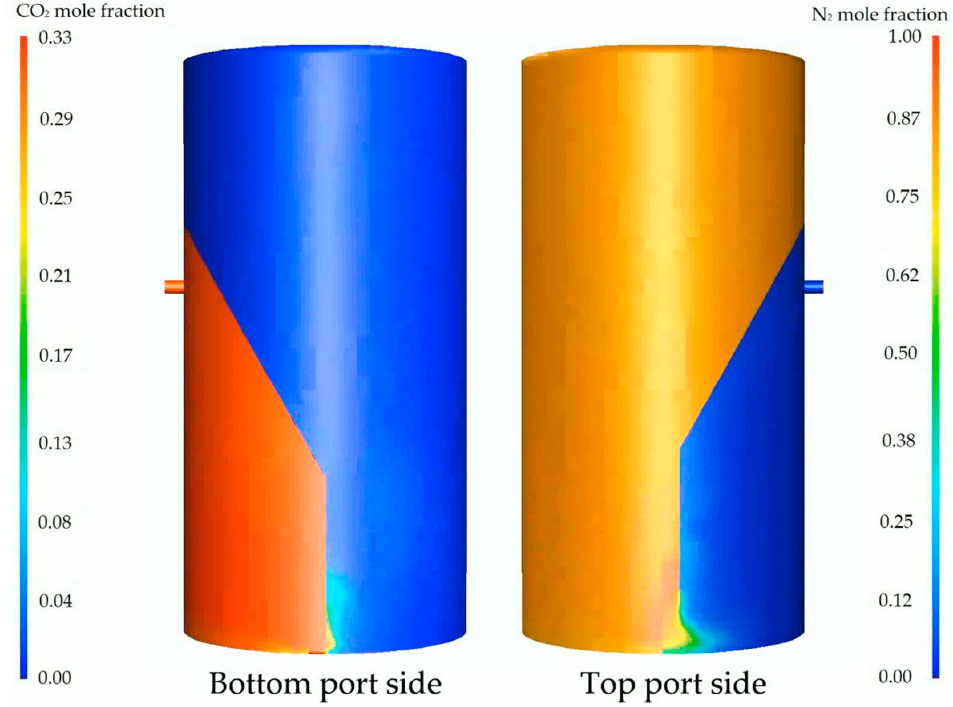
Figure 6. Contour plot of the instantaneous CO 2 and N 2 mole fractions at the outer wall of the ICR showing the undesired gas leakage between the two sections of the reactor. A corresponding animation is provided in Video S2.